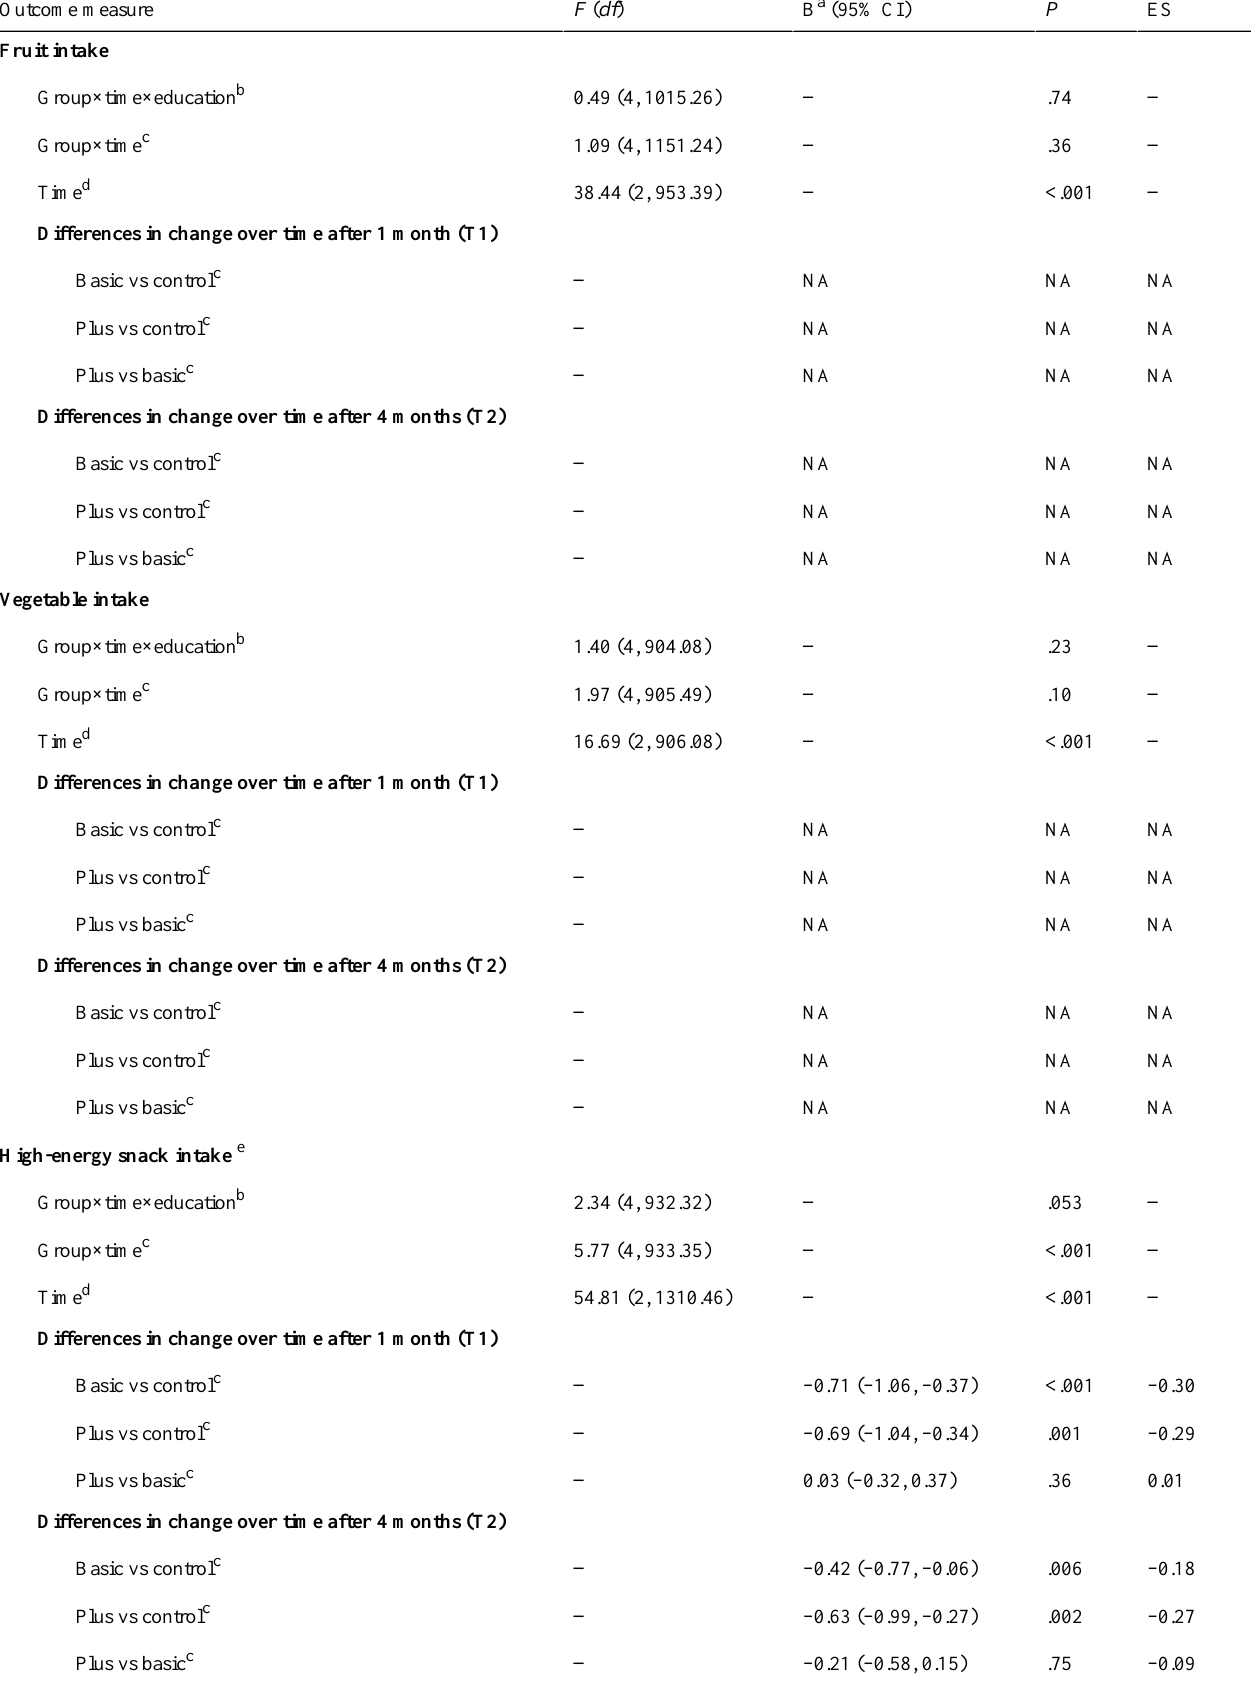
Table 3. Results of linear mixed model analyses for the total sample